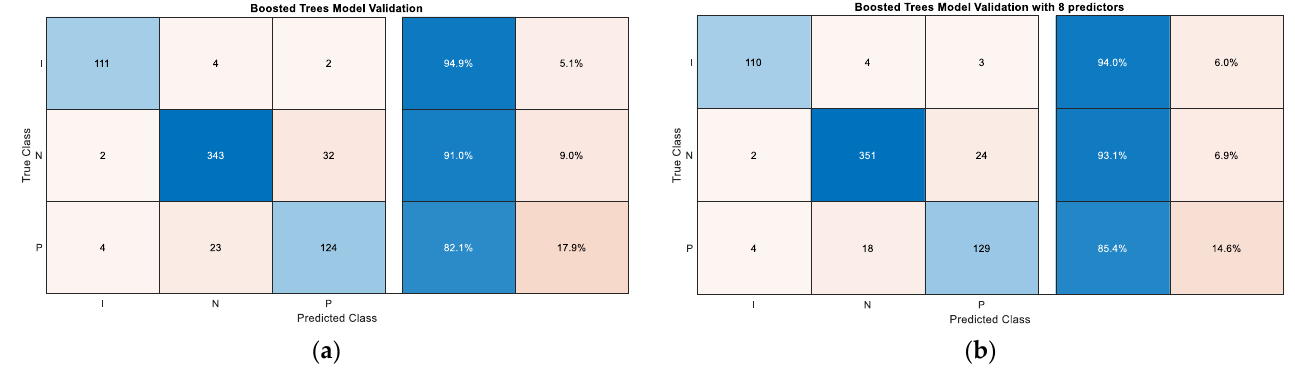
Figure 10. ( a ) Confusion matrix of the Boosted Trees model after validation; ( b ) Confusion matrix of the Boosted Trees model with 8 predictors after